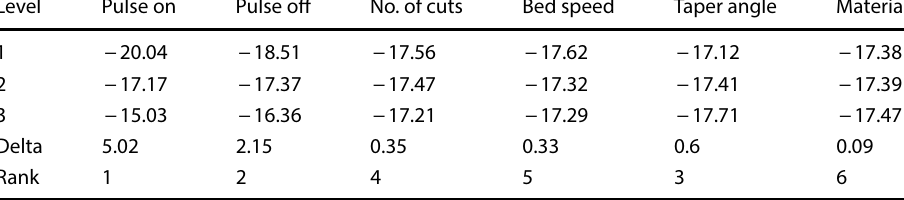
Table 10 Response table for Level Pulse on Pulse off No. of cuts Bed speed Taper signal to noise ratios ( MRR )